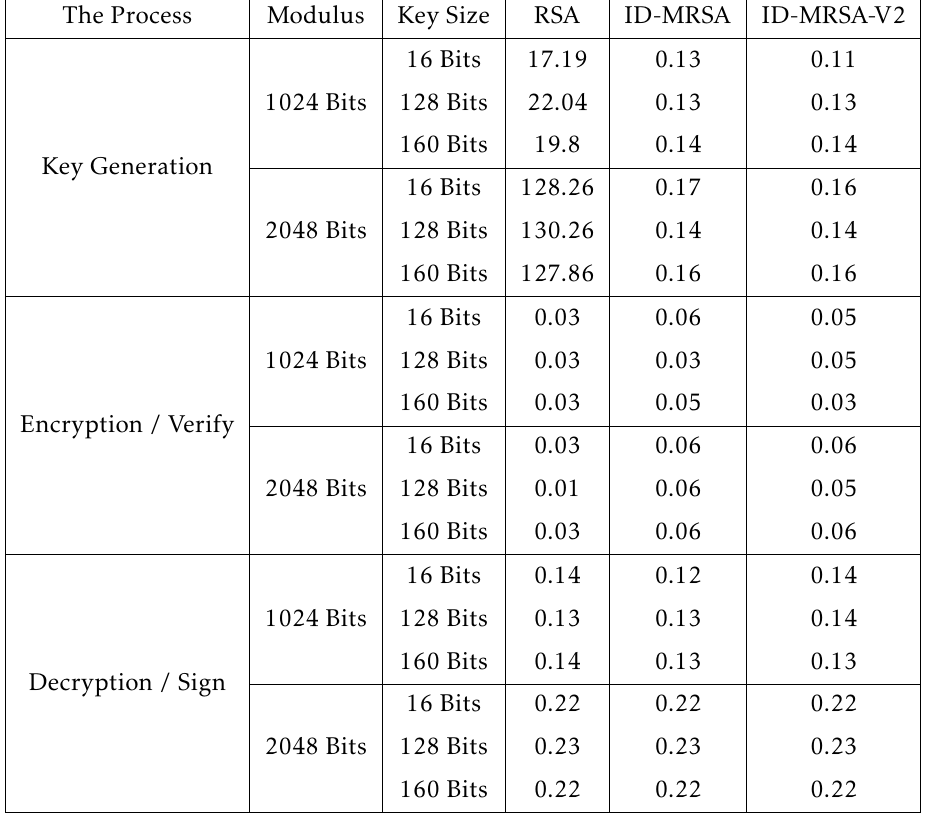
Table 2. The time